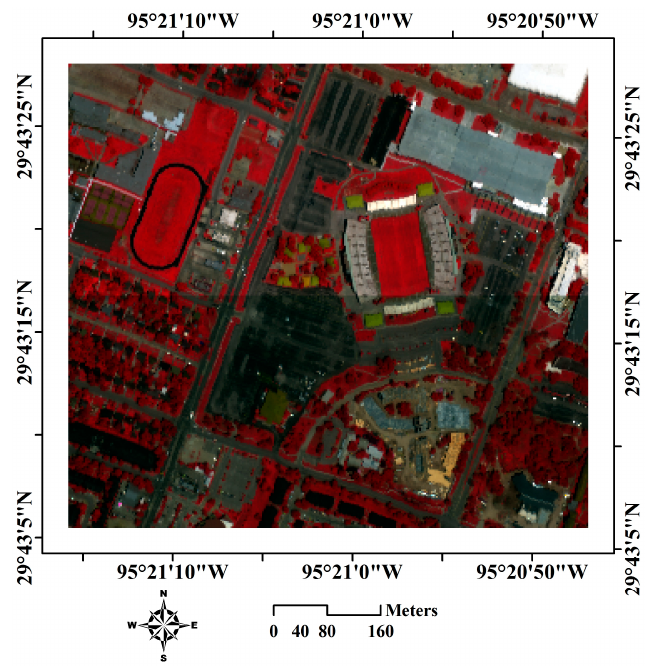
Figure 12. False color image of the 3rd test area.